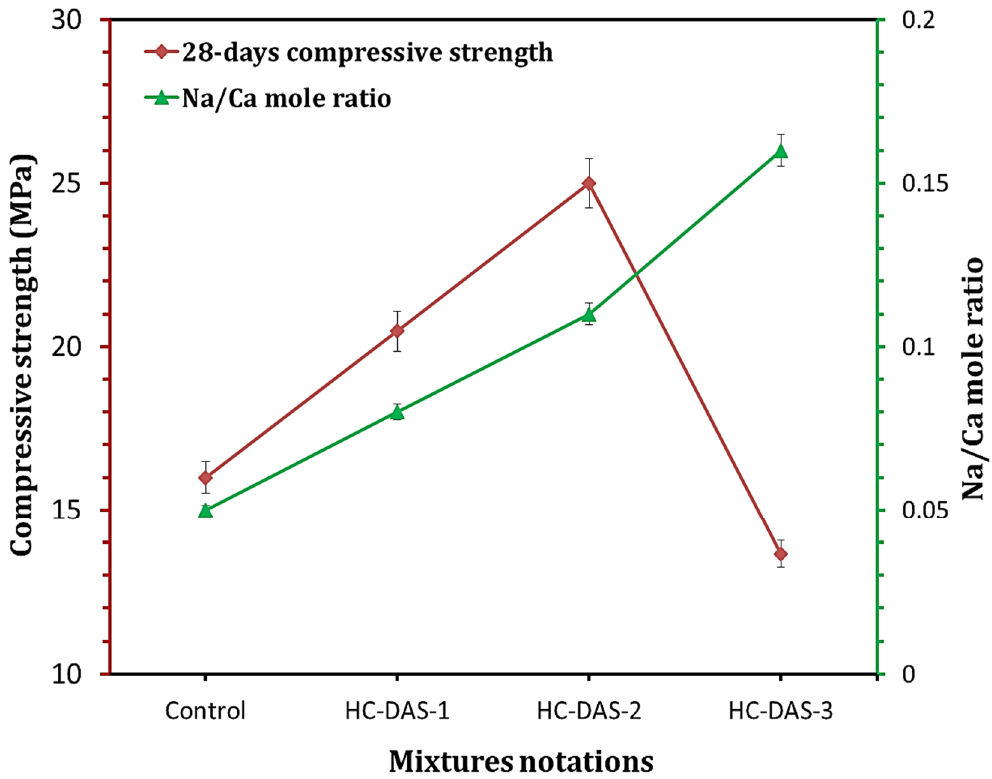
Figure 11. Relationship between Na/Ca ratio and compressive strength of the 28-days hardened mortars having different DAS contents.